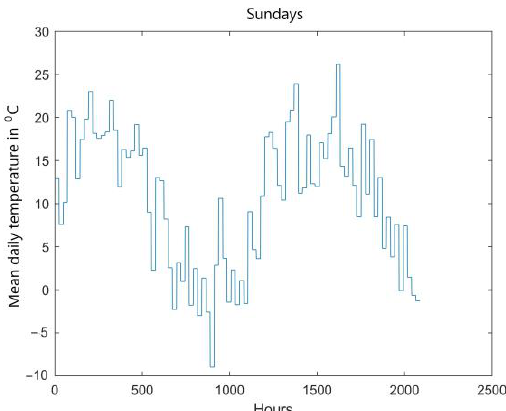
Figure 5. Curves of mean daily temperature (°C) in the area of the power company within subsequent days of the week—data from ca. 2 years (Source: own work).